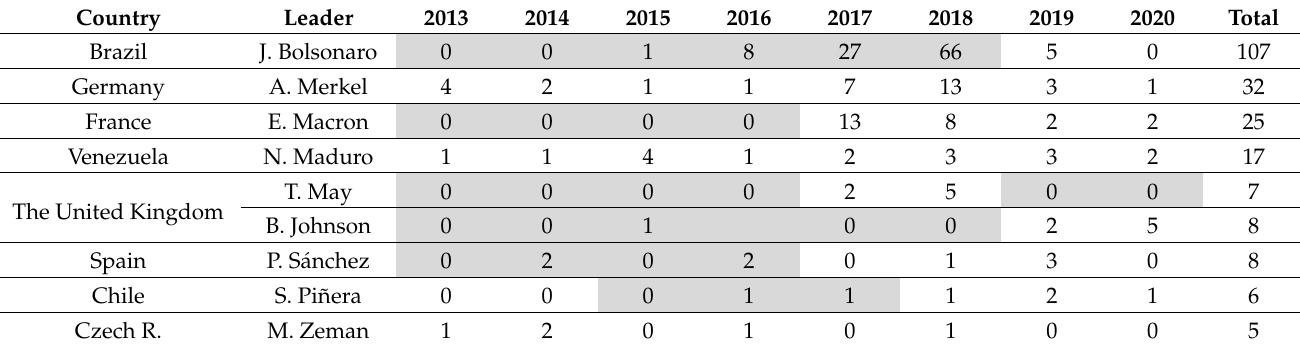
Table 3. Presence of the most popular politicians in the mobile ecosystem.